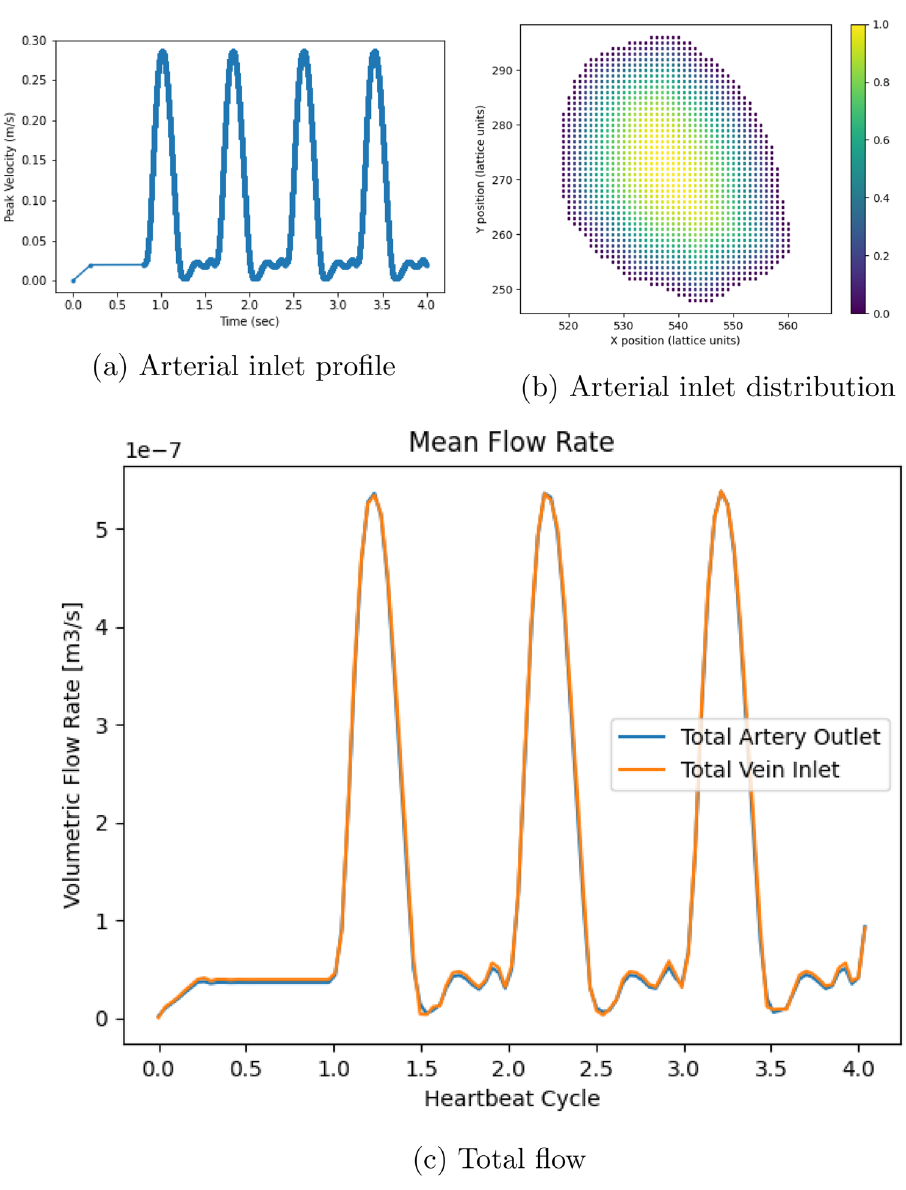
Figure 2. Simulation inlet conditions used in all studies and the observed response in the healthy vessels. ( a ) details the flow velocity provided to the inlet of the arterial geometry for the forearm flow cases. The first 0.8s of the flow represents an initial warm-up period of flow within the system. ( b ) indicates the distribution of scaling weights applied to the flow velocity at the inlet of the arterial geometry. ( c ) compares the total inlet and outlet flow rate through the healthy